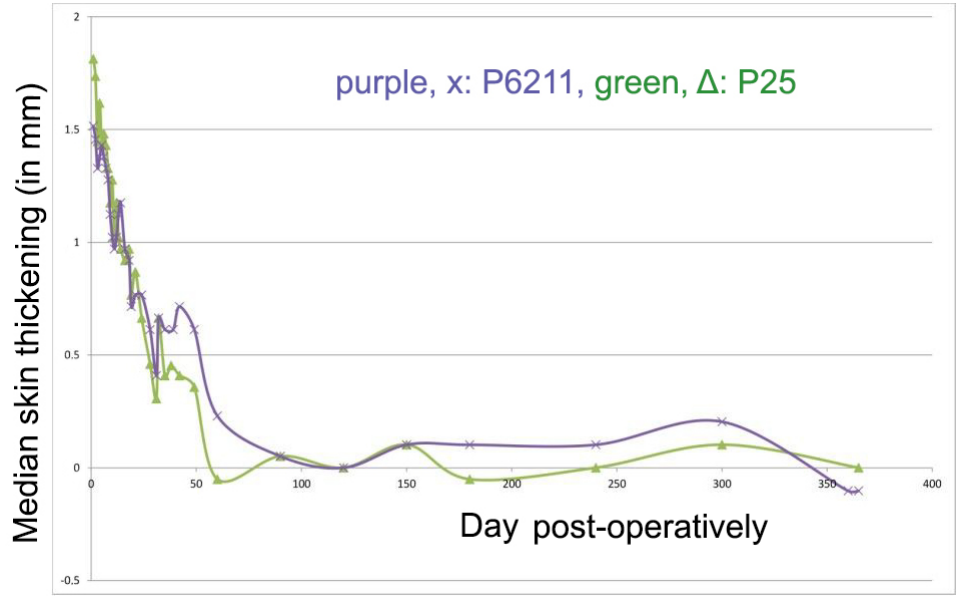
Figure 1. Median skin thickening (mm) for each suturing material (purple: P6211; green: P25) during